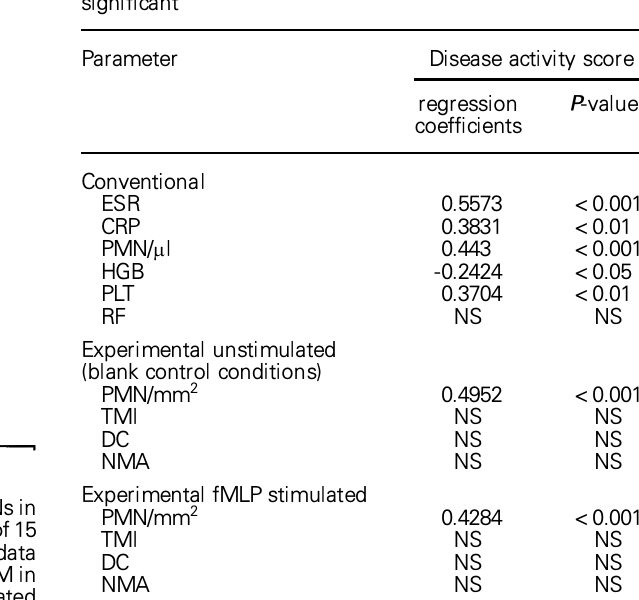
Table 2. RA disease activity scoring versus conventional a and experimental b RA parameters. Regression coefficient values between disease activity and parameters are shown if